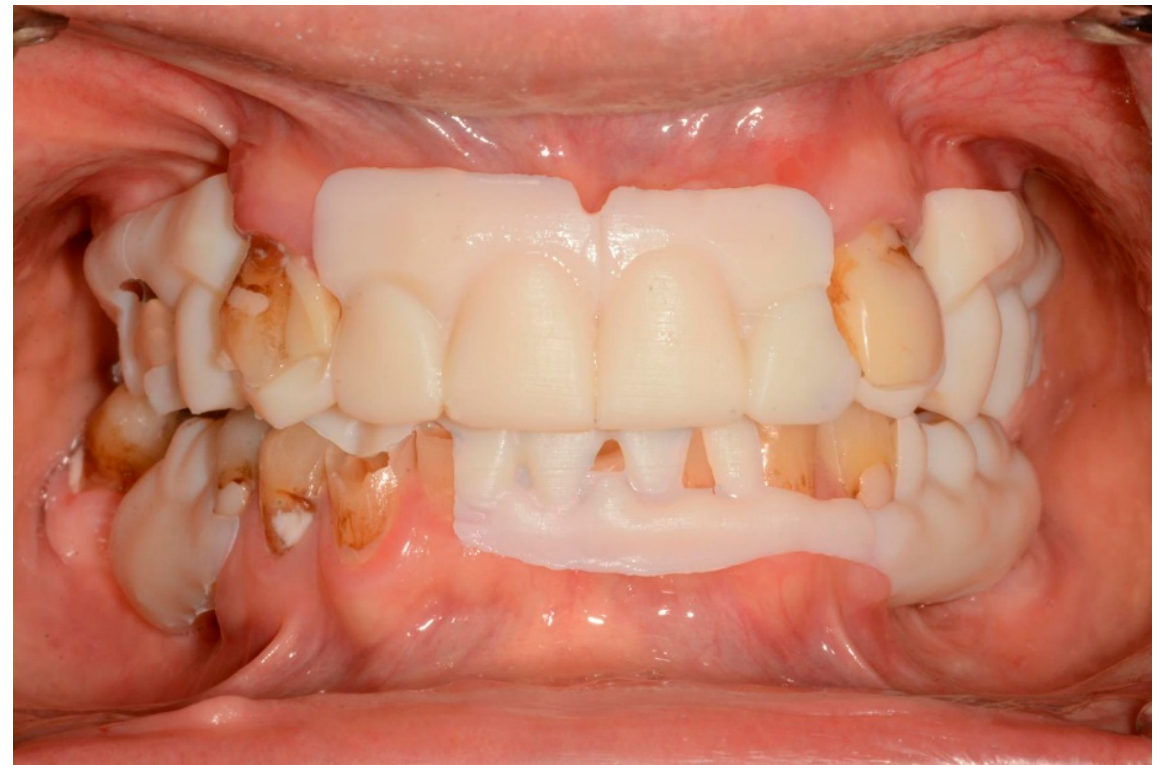
Figure 9. Intraoral evaluation of the 3D-printed overlay templates. Note satisfactory re-establishment of the vertical dimension of occlusion, occlusal plane, and anterior teeth relationships with these non-invasive diagnostic appliances.